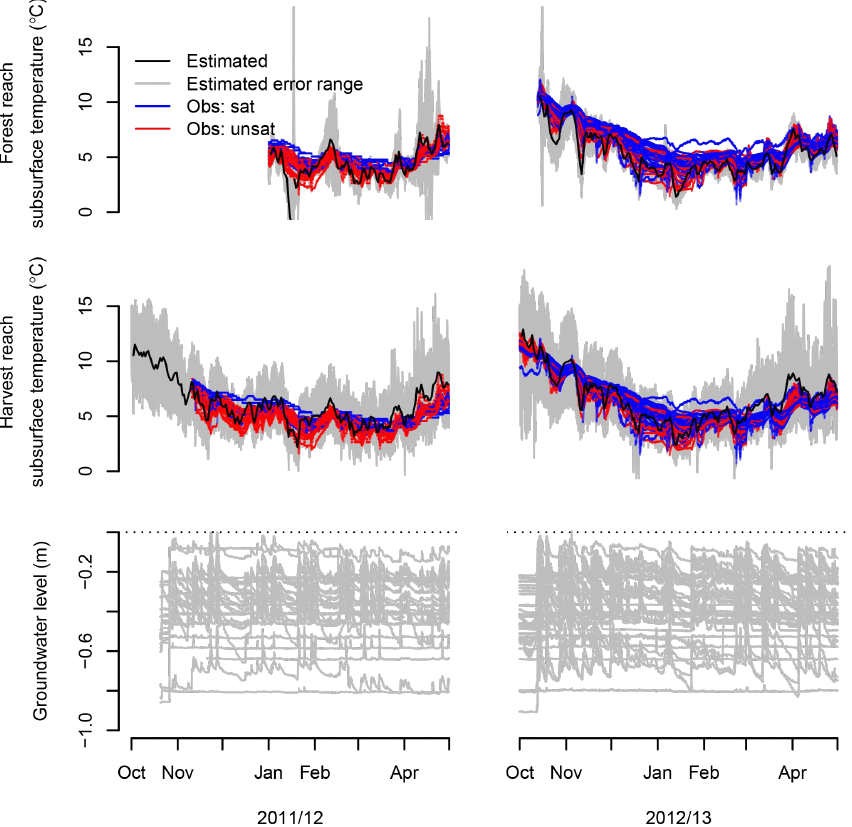
Fig. 6. Comparison of back-calculated effective advective temperature and observed near-stream subsurface temperatures, as well as ground- water table observations for the 2011/2012 and 2012/2013 winter periods. The black lines are the calculated effective advective temperature and the grey bands represent the probable error range. During periods where the subsurface temperature logger is below the water table the observed temperature line is blue, and it is red for periods when the logger is above the water